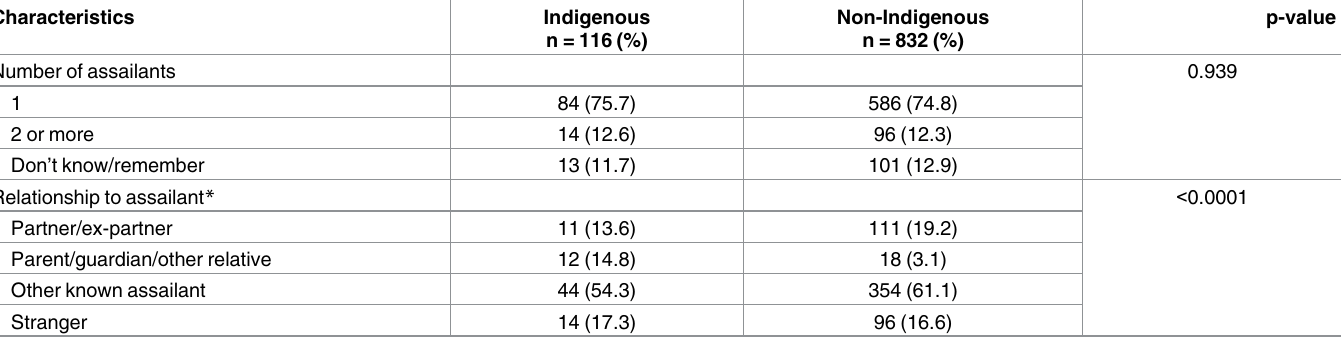
Table 3. Assailant characteristics of sexually assaulted adolescent and adult women who presented to Sexual Assault/Domestic Violence Treat- ment Centres, by Indigenous